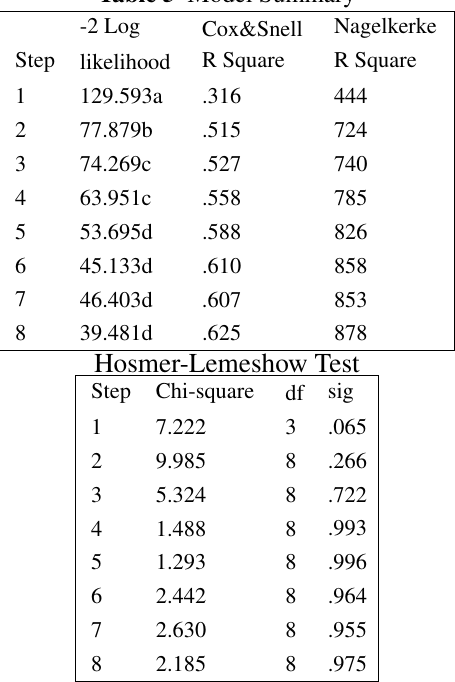
Table 5 Model Summary